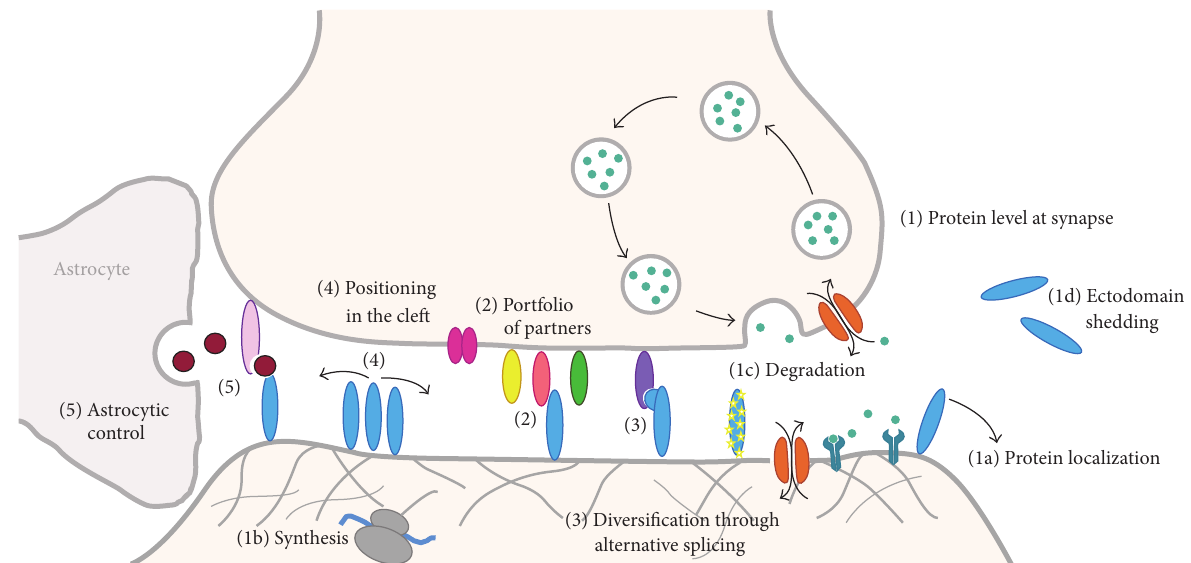
Figure 3: SAMs can contribute to synaptic plasticity. SAM function can be regulated by synaptic activity through different processes. Protein levels can change (1) as a result of altered localization targeting a protein to or away from the synaptic membrane surface (1a), protein synthesis (1b), protein degradation (1c), and ectodomain shedding (1d). The availability of members within a broad portfolio of potential partners can be altered (2). SAMs can be diversified through alternative splicing (3). SAMs can be repositioned in the synaptic cleft (4). Protein interactions supported by SAMs can be modulated by astrocytic factors (5). Details are as discussed in the